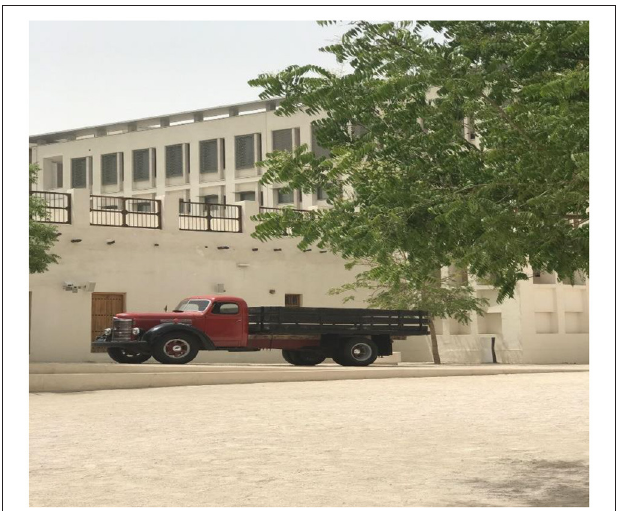
FIGURE 3 | The truck that was used to transfer Qatari oil laborers from Doha to Dukhan and Mesaieed in the South and back. Displayed in the museum courtyard. Taken by the author in May 2018.